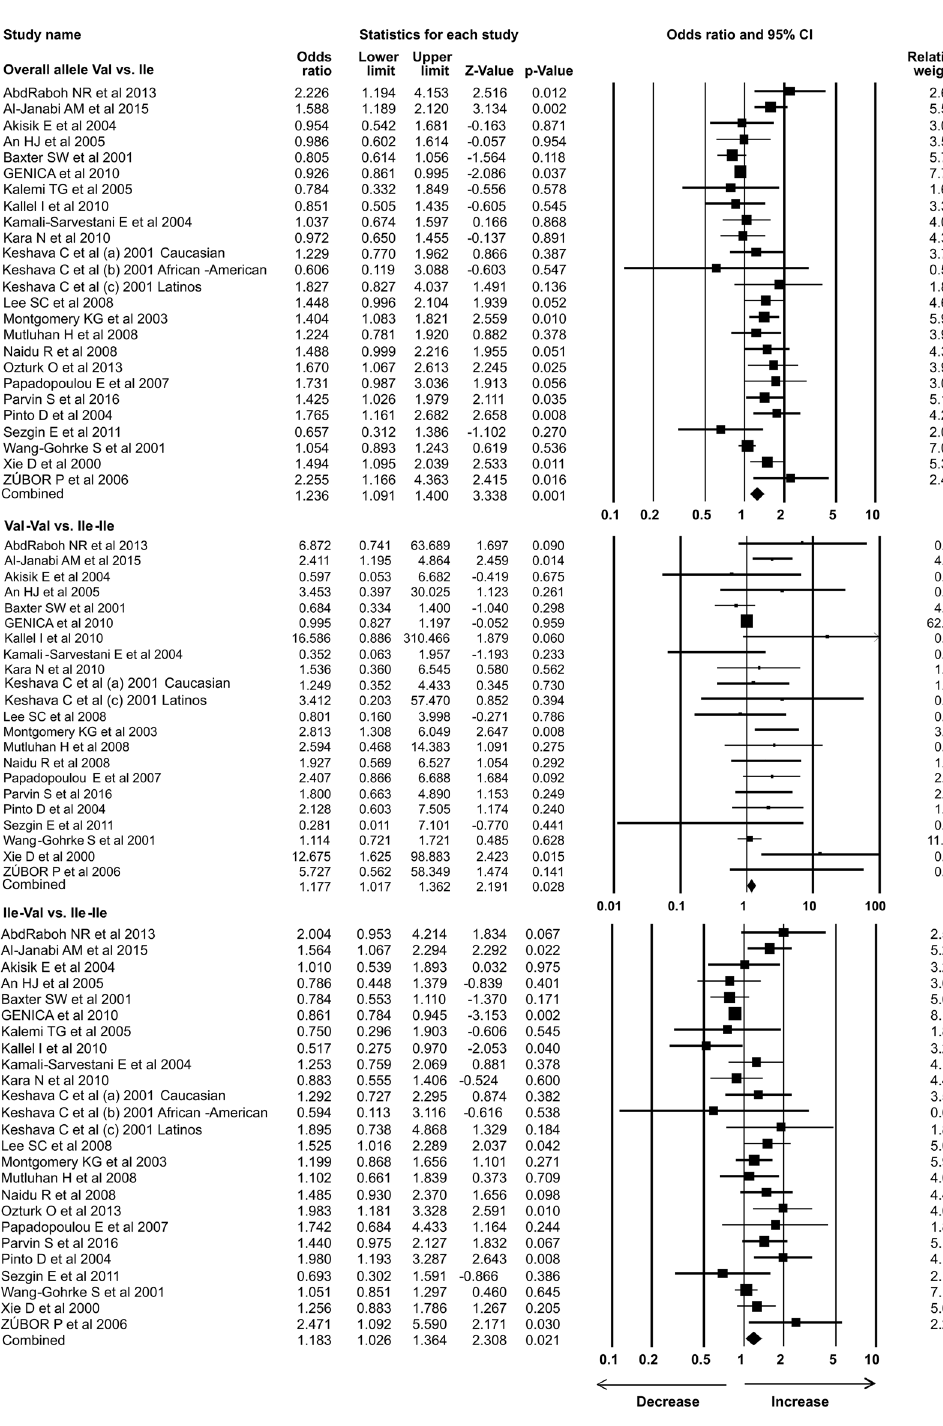
Figure 4. Forest plot: Overall allele and genotypic (Homozygous: Val-Val vs. Ile-Ile and Heterozygous: Ile- Val vs Ile-Ile) analysis of studies in which RFLP used as detection method for Her2 Ile 655 Val (rs1136201) gene polymorphism and evaluation of its association with breast cancer risk. Black squares represent the value of OR and horizontal line indicates 95% Confidence Interval (CI) of odds ratio